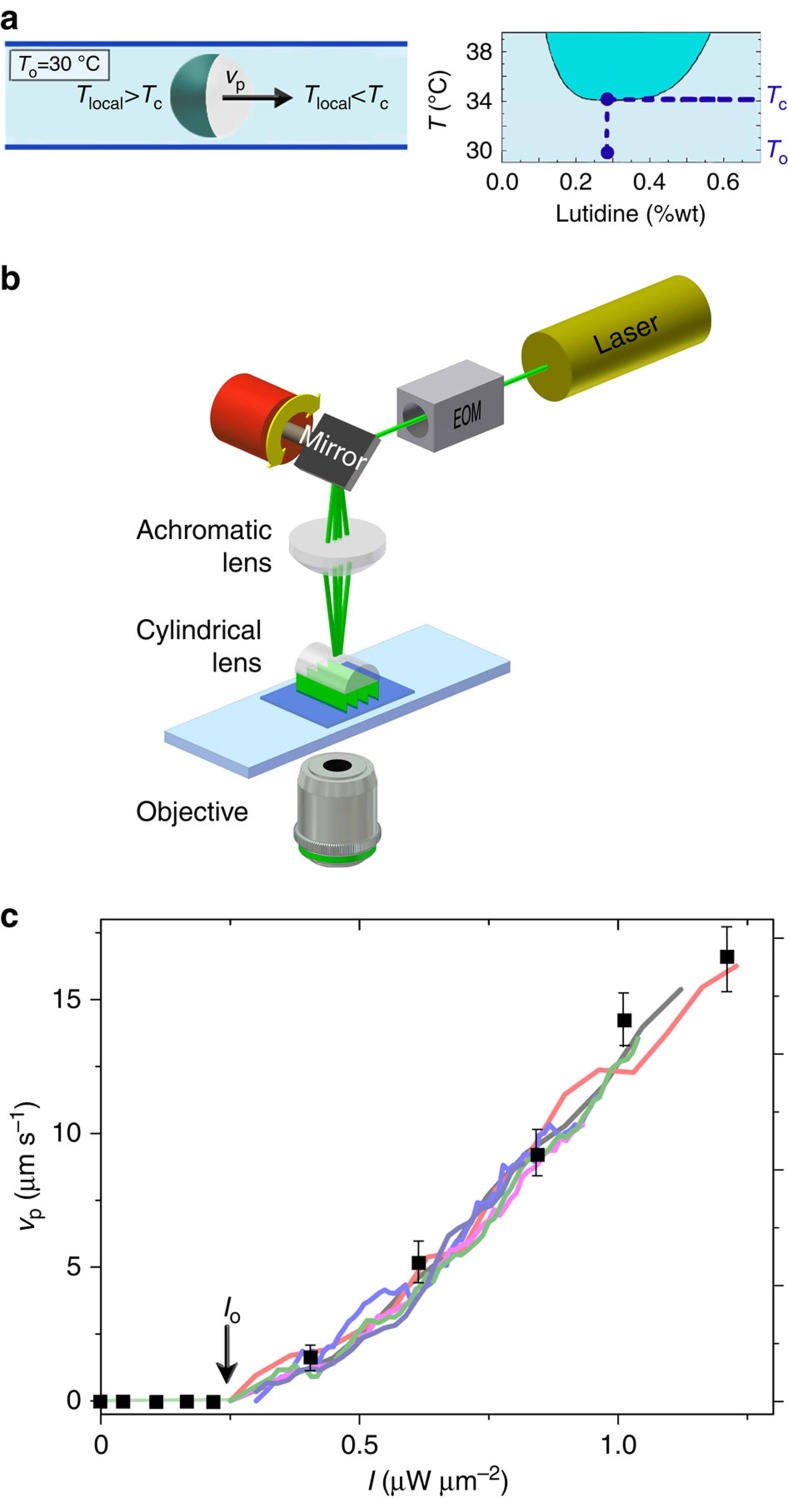
Light-activated self-propulsion mechanism.(a) Sketch of the sample cell with a capped particle suspended in a binary critical mixture of water–2,6-lutidine. Illumination with light leads to heating of the cap and thus to local demixing resulting in active motion. (b) Experimental set-up for creation of periodic illumination landscapes by a scanned line focus of a laser beam (Methods). (c) Propulsion velocity vp versus illumination intensity I. Symbols (with error bars representing the s.d.) correspond to homogeneous illumination of the sample cell, while coloured lines were obtained in the presence of light profiles with different gradients (|∇I|=2 × 10−3 μW μm−3 (pink), 0.027 μW μm−3 (green), 0.037 μW μm−3 (red), 0.115 μW μm−3 (blue) and 0.156 μW μm−3 (grey)). The agreement between the data for different intensity gradients demonstrates that vp is only determined by the local intensity incident on the particle.